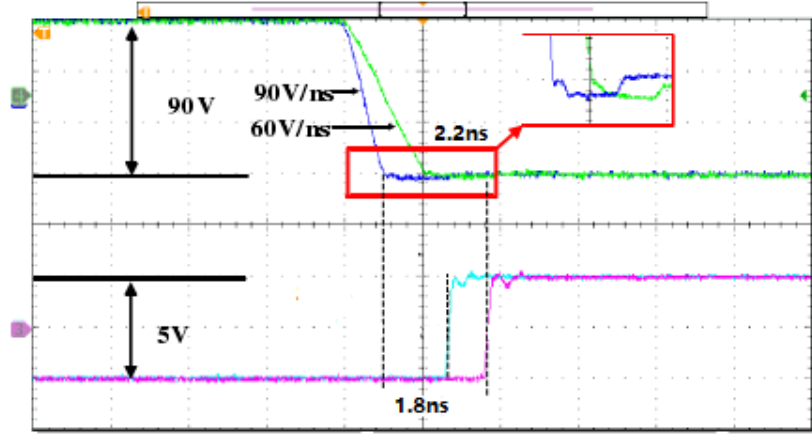
Figure 13. Low-side test results.